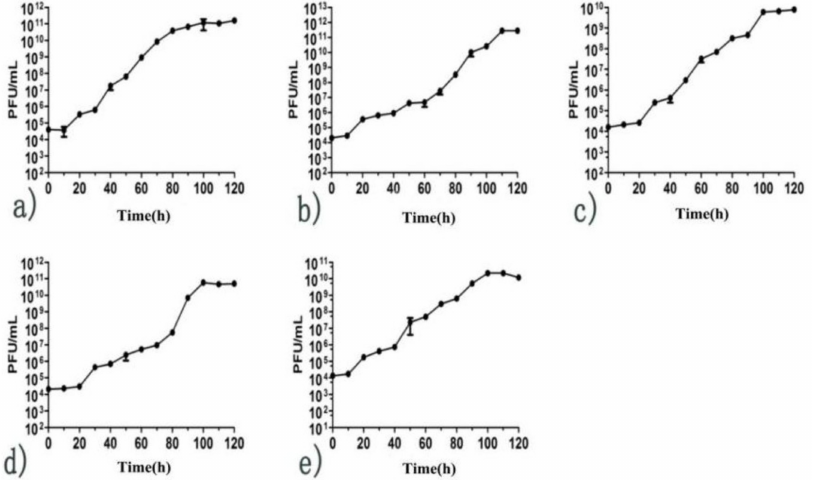
Figure 4. One-step growth curve of S. aureus phages isolated from clinical mastitis. The results are shown as the mean ± standard deviation from three independent experiments. The one-step growth curve showed a short latency period (10–20 min) and high burst size (up to 400 PFU/infected cells). ( a ) Phage 4086-1; ( b ) Phage 4086-2; ( c ) Phage 4086-3; ( d ) Phage 4086-4; ( e ) Phage